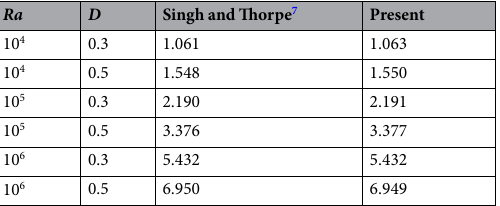
Table 1. Comparison of Nu for Darcy model for porous media with horizontal partition at a constant left and right wall temperature for Da = 10 − 4 and φ =